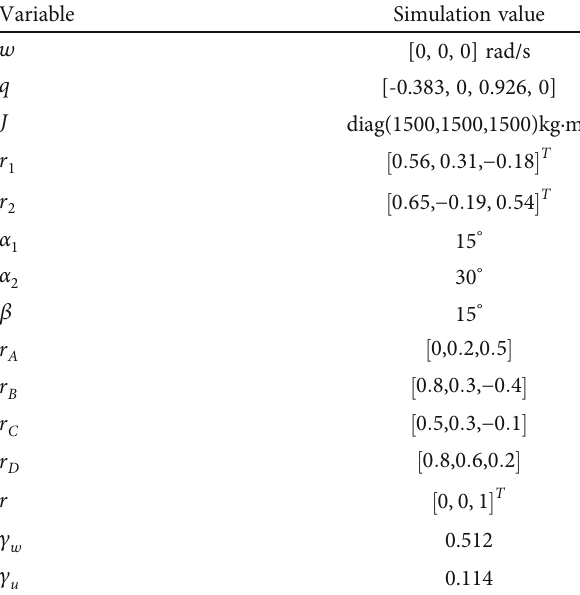
Table 2: Numerical simulation of spacecraft operating parameters.